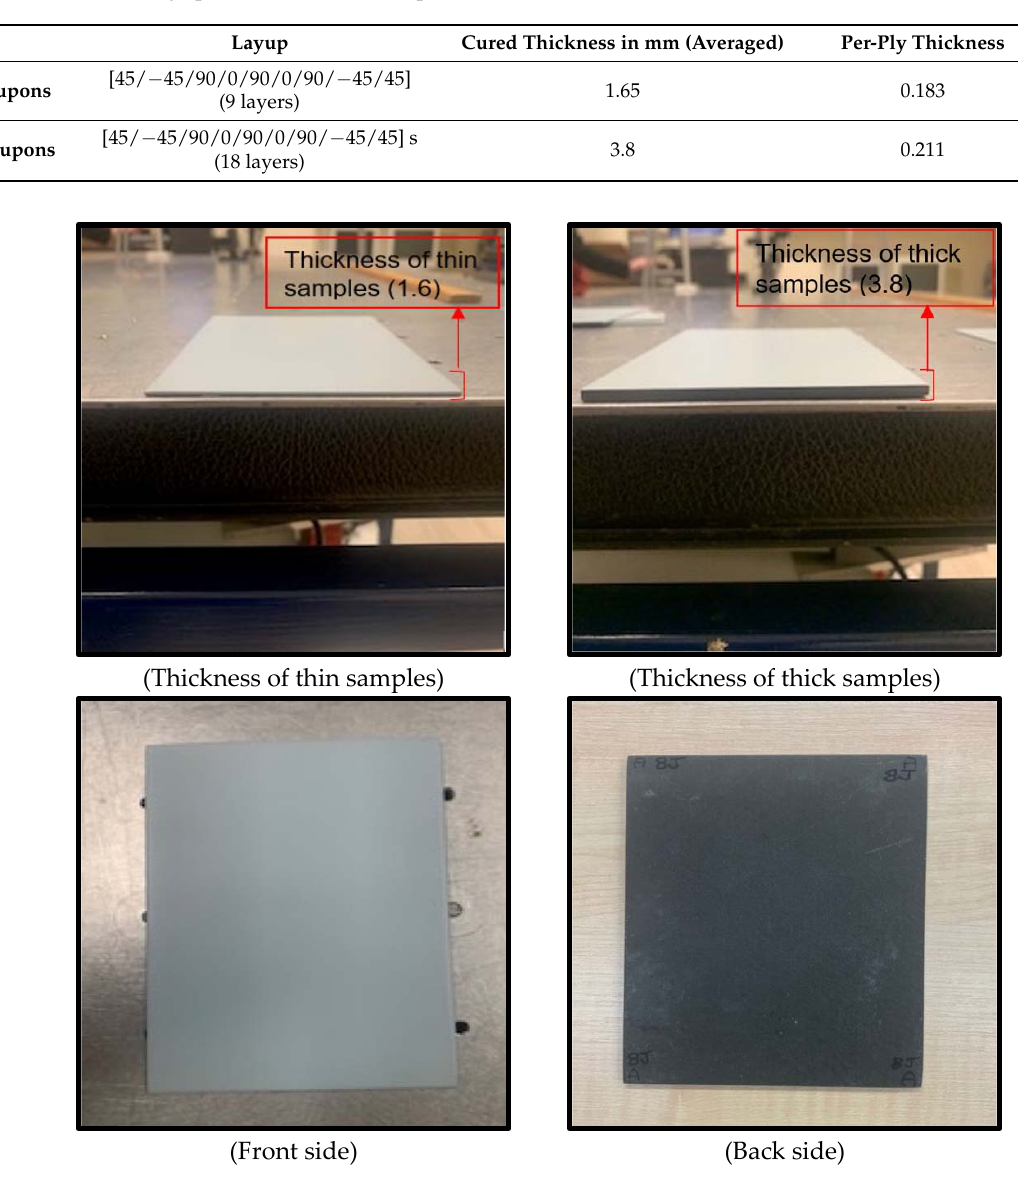
Figure 1. Samples feature.